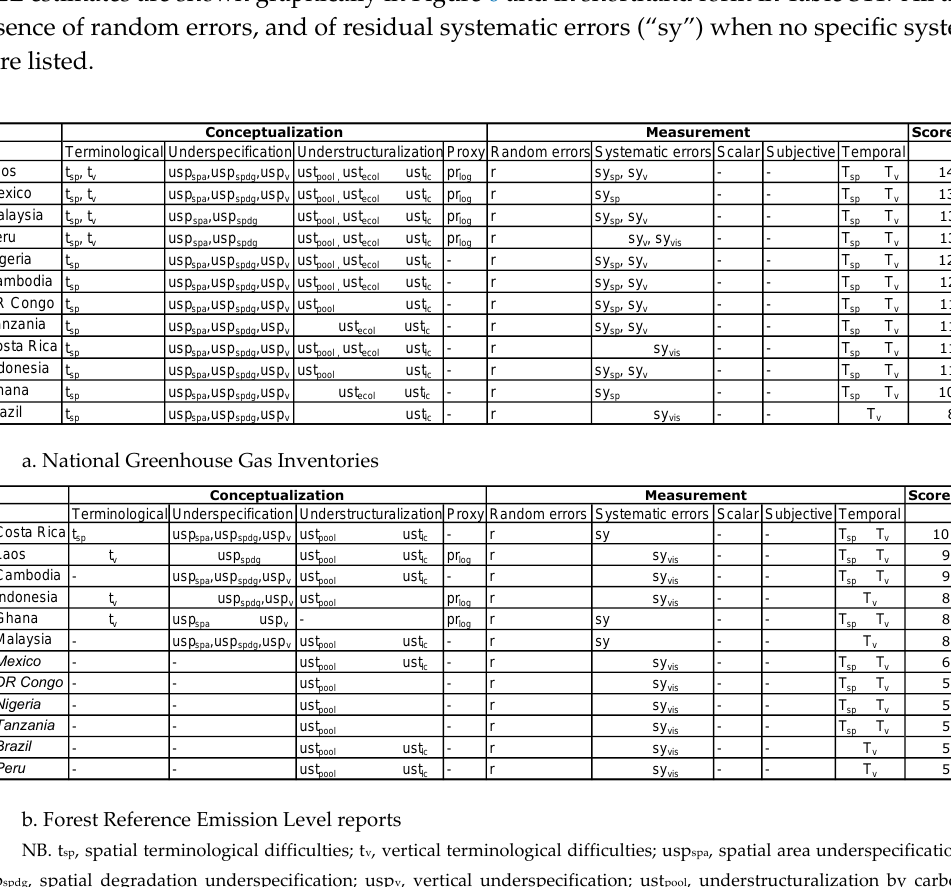
Figure 6. Uncertainty Fingerprints for twelve tropical countries of estimates in ( a ) National Greenhouse Gas Inventories; and ( b ) Forest Reference Emission Level reports (the partial group of countries in italics only report emissions from deforestation) [54 – 77].